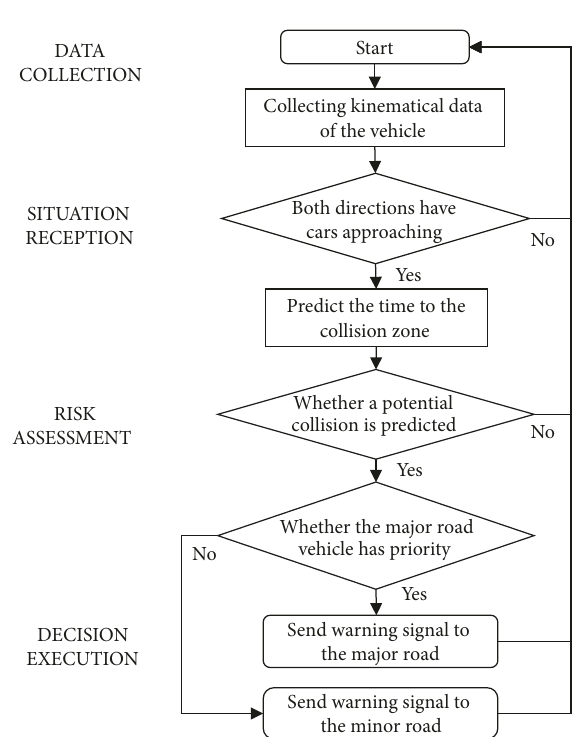
Figure 1: Hierarchical framework of the warning system.